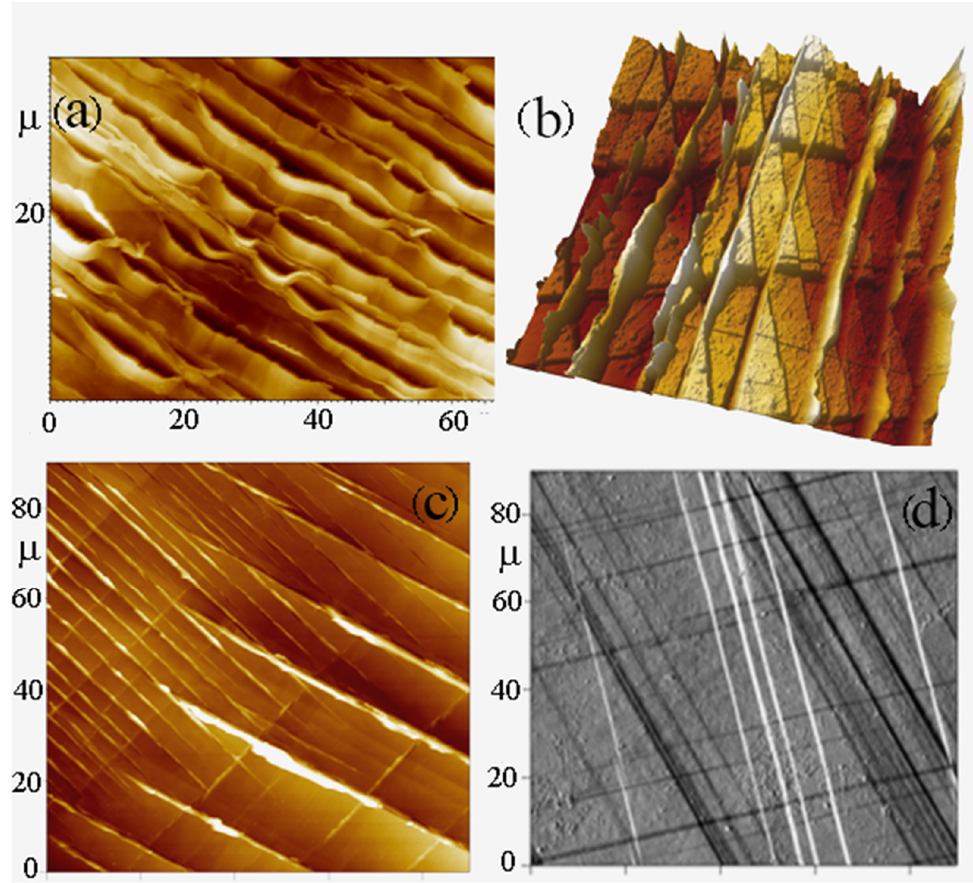
Figure 8. AFM images of the free surface of specimen 2. ( a ) General view of the crack tip; ( b ) typical slip steps and extrusions in area J; ( d ) Intensive slip in area L; ( c , e ) two views of area K illustrate the fading of the slip lines with increasing distance from the crack.